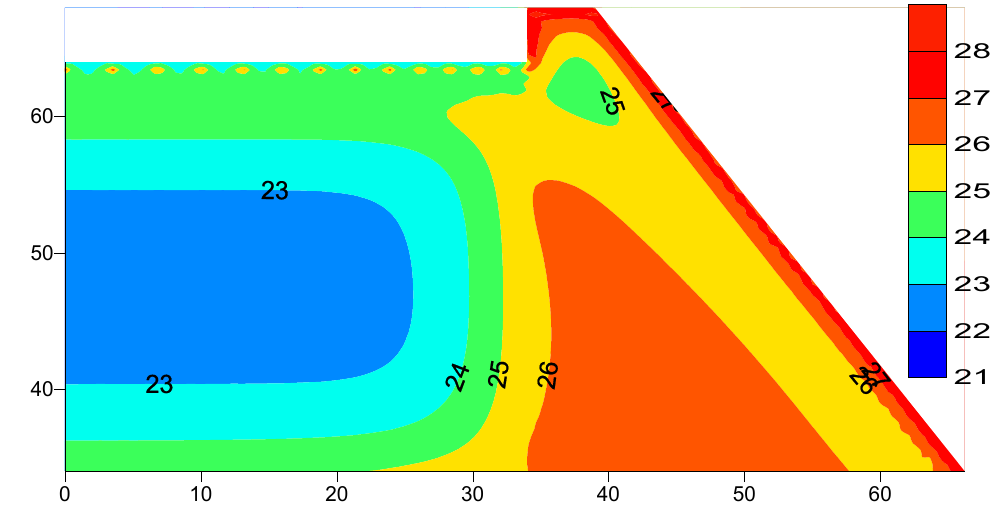
Figure 7. Reservoir dam body temperatures distribution after three years of filling ( °C ).